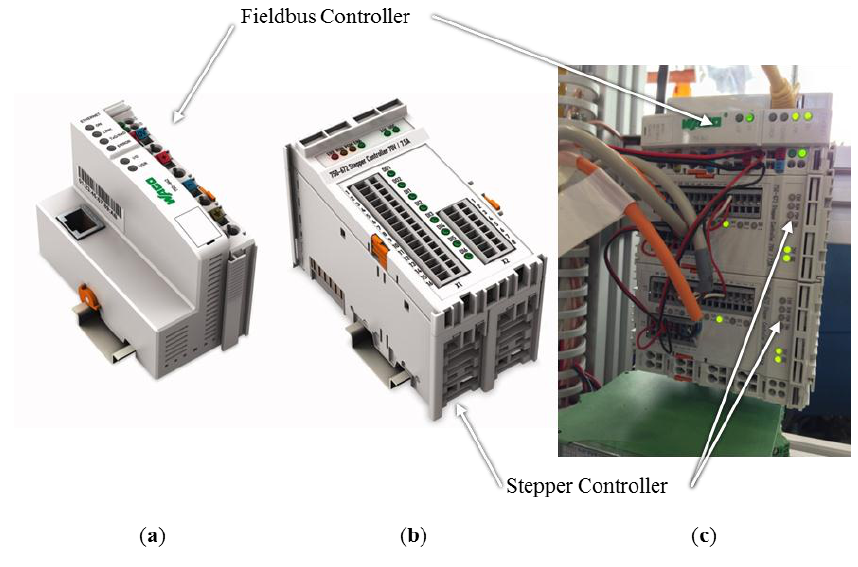
Figure 8. ( a ) Fieldbus Controller 750-842 [9], ( b ) stepper controller 750-672 (middle)